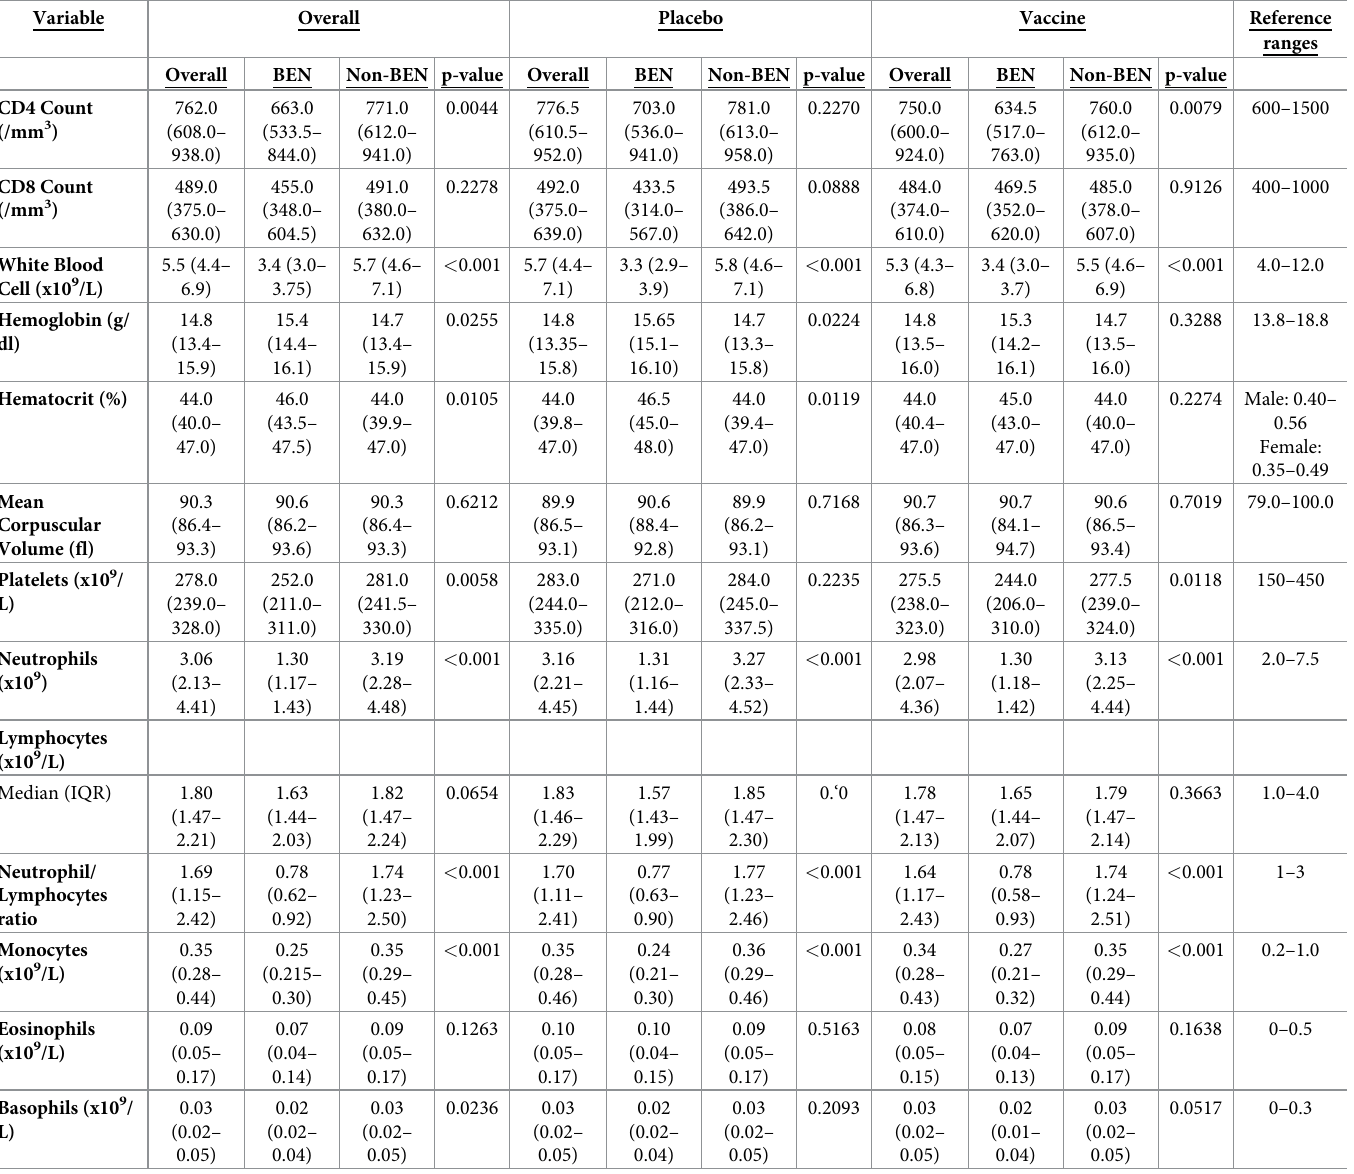
Table 2. Median (IQR) laboratory measures at baseline by BEN of Black participants in HVTN 503.